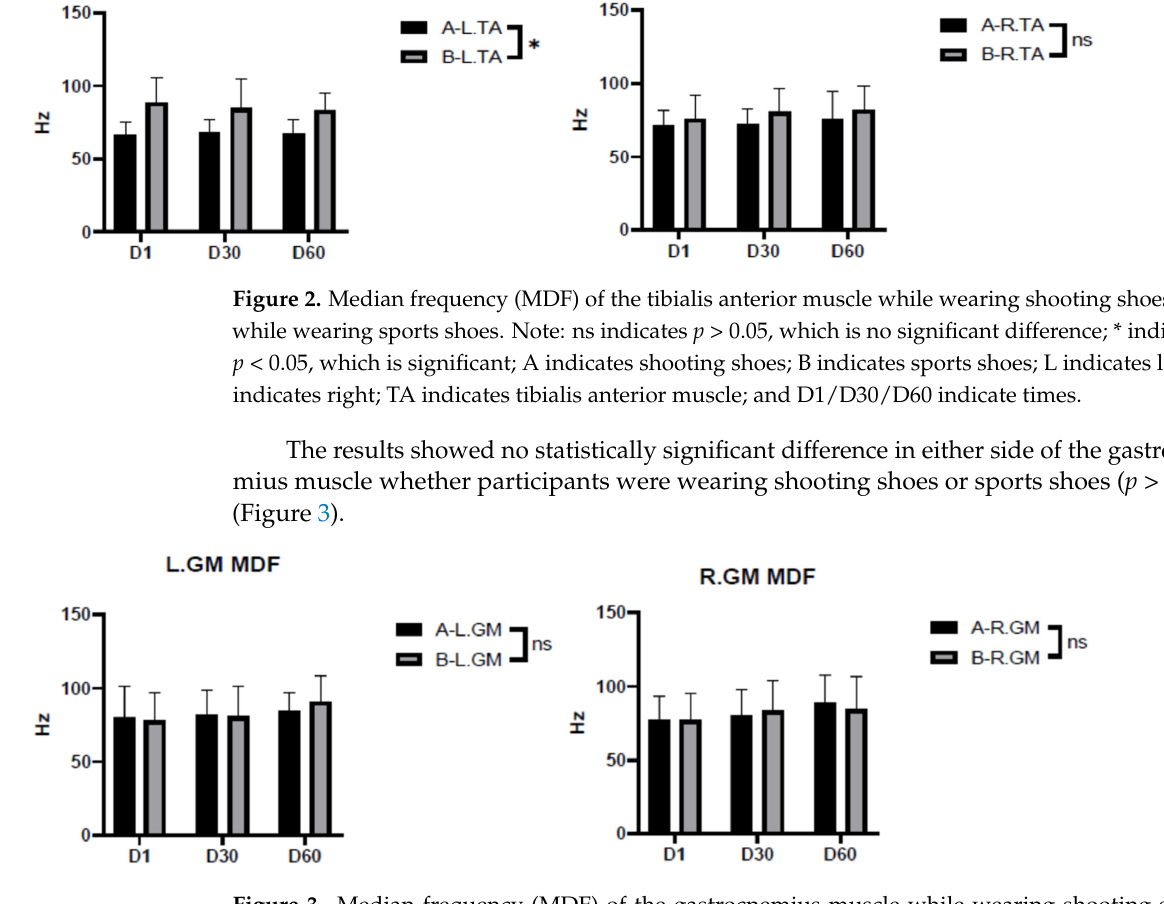
Figure 3. Median frequency (MDF) of the gastrocnemius muscle while wearing shooting shoes and